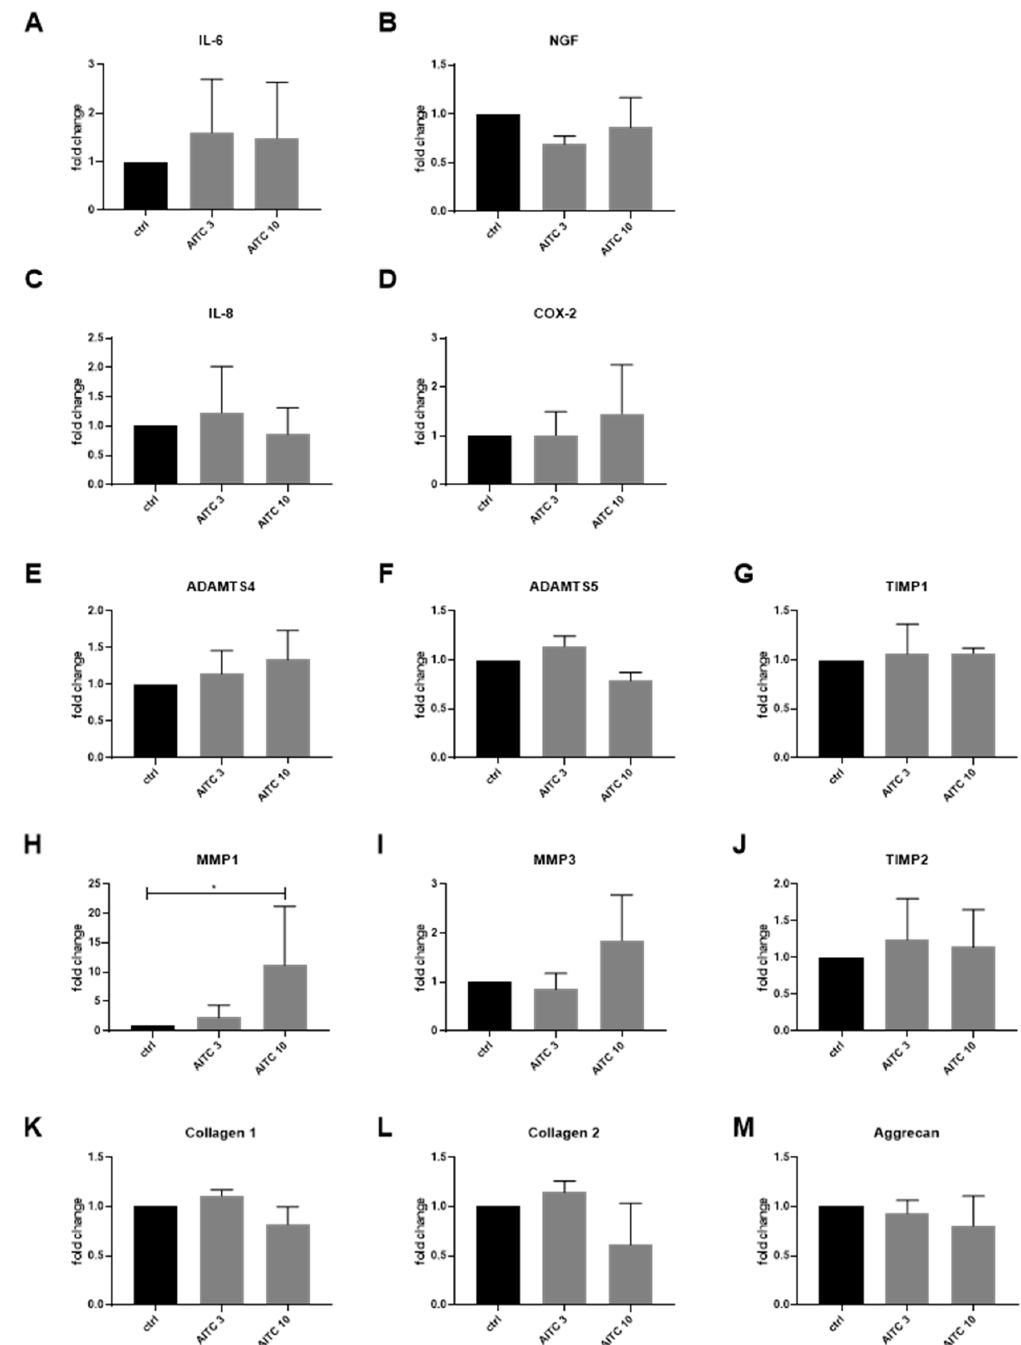
Figure 4. The effects of TRPA1 agonist allyl isothiocyanate (AITC) on the gene expression of inflammation markers and extracellular matrix (ECM) molecules in IVD cells without cytokine pre- treatment. Gene expression of ( A ) interleukin-6 (IL-6), ( B ) nerve growth factor (NGF), ( C ) interleukin 8 (IL-8), ( D ) cyclooxygenase-2 (COX-2), ( E ) ADAMTS4, ( F ) ADAMTS5, ( G ) tissue inhibitor of matrix metalloproteinase 1 (TIMP1), ( H ) matrix metalloproteinase 1 (MMP1), ( I ) matrix metalloproteinase 3 (MMP3), ( J ) tissue inhibitor of matrix metalloproteinase 2 (TIMP2), ( K ) COL1A1, ( L ) COL2A1, and ( M ) Aggrecan in IVD cells treated with 3 and 10 µM AITC. Graphs show gene expression and protein release calculated relative control (2 − dd C t , mean ± SD, n = 3). Asterisks indicate statistical significance (* p < 0.05, Kruskal–Wallis test and Dunn’s multiple comparison test).